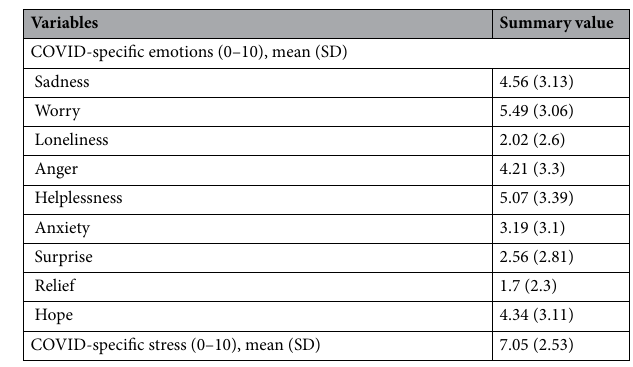
Table 2. Baseline descriptive characteristics of cohort.